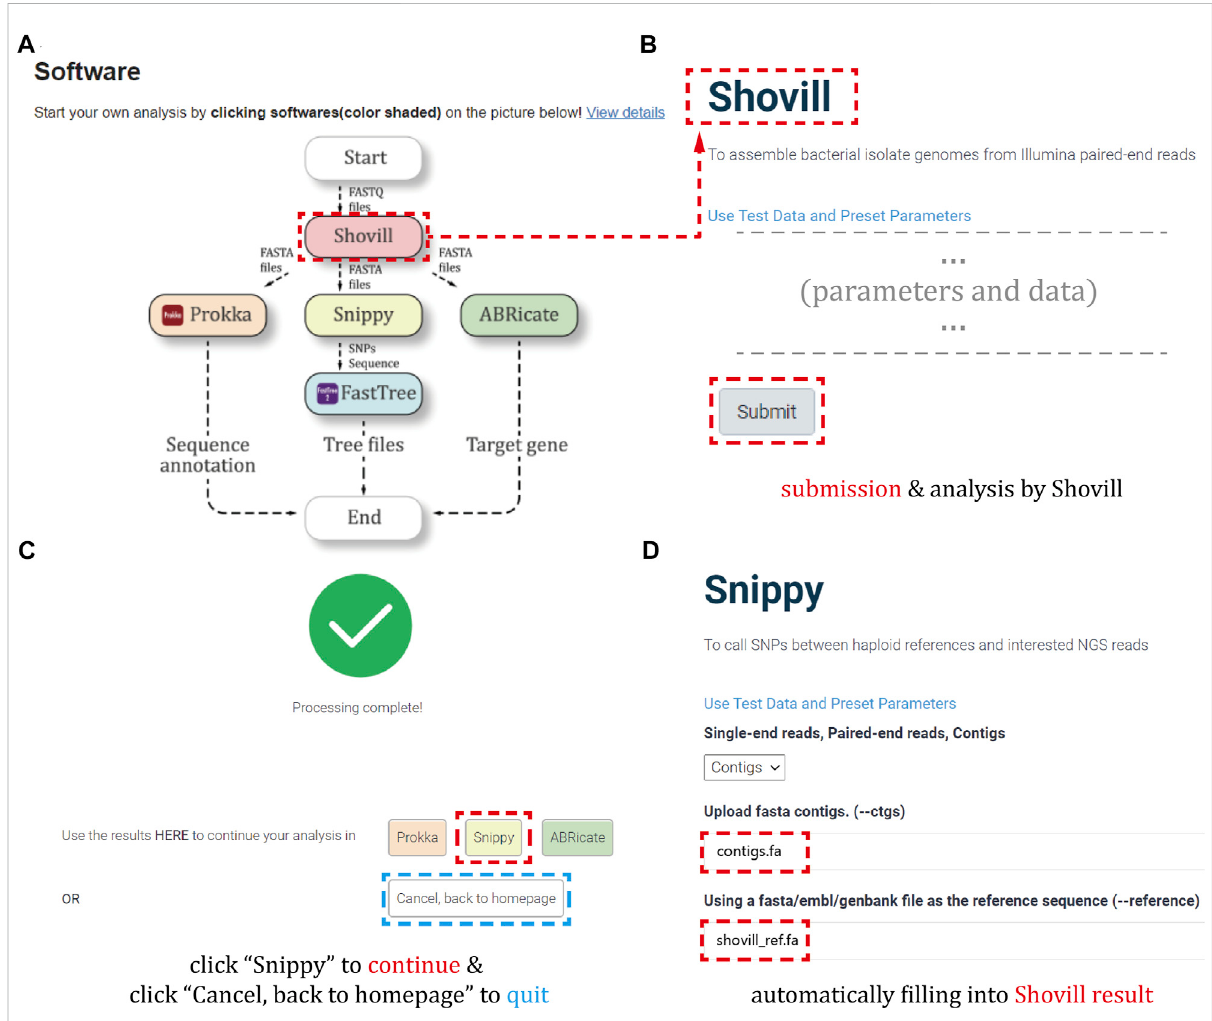
FIGURE 4 Analysis work fl ow. (A) The fl owchart of the software analysis procedures on the homepage. (B) The example of starting a genomic analysis by data submission and parameter selection. (C) The interface of selecting corresponding software to continue the work fl ow when the analysis is completed. (D) The example of automatically fi lling results from previous step to the current